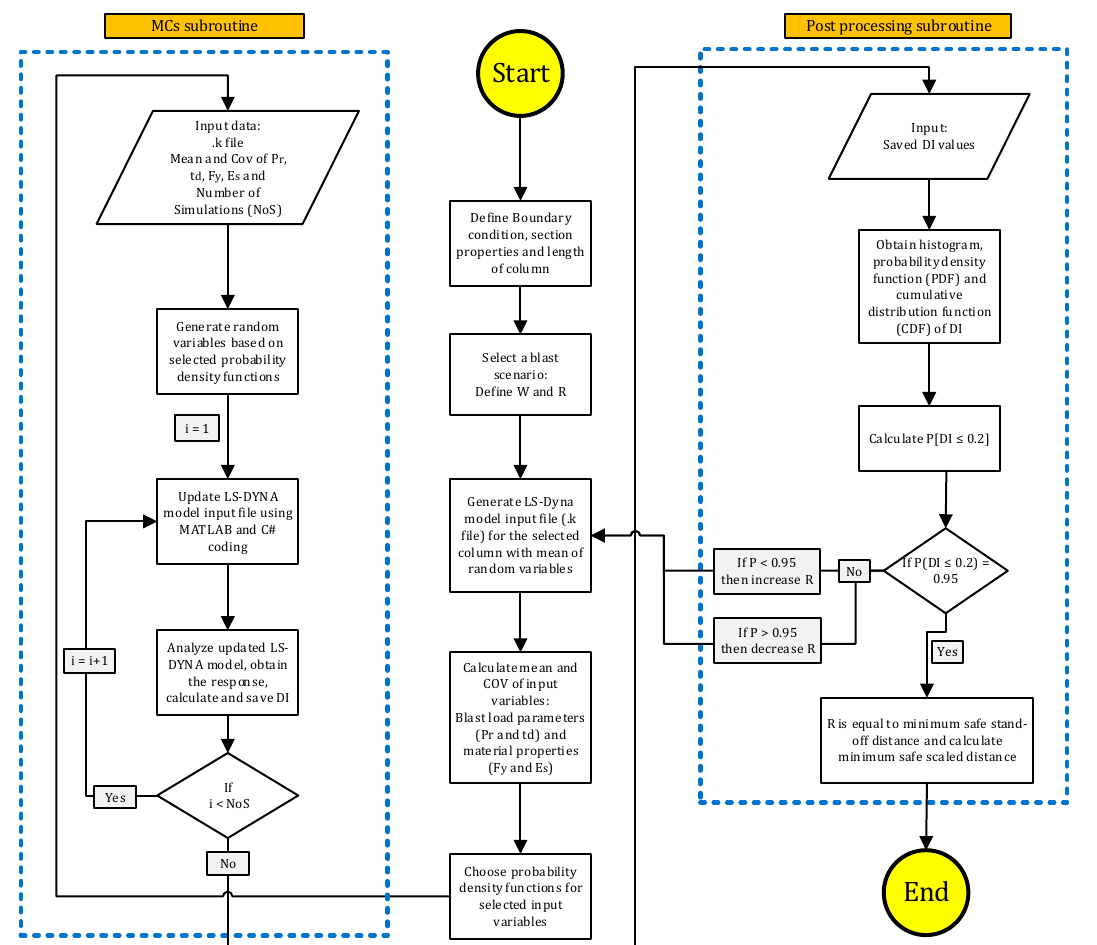
Figure 4. Procedures for SSD derivation based on structural reliability approach.